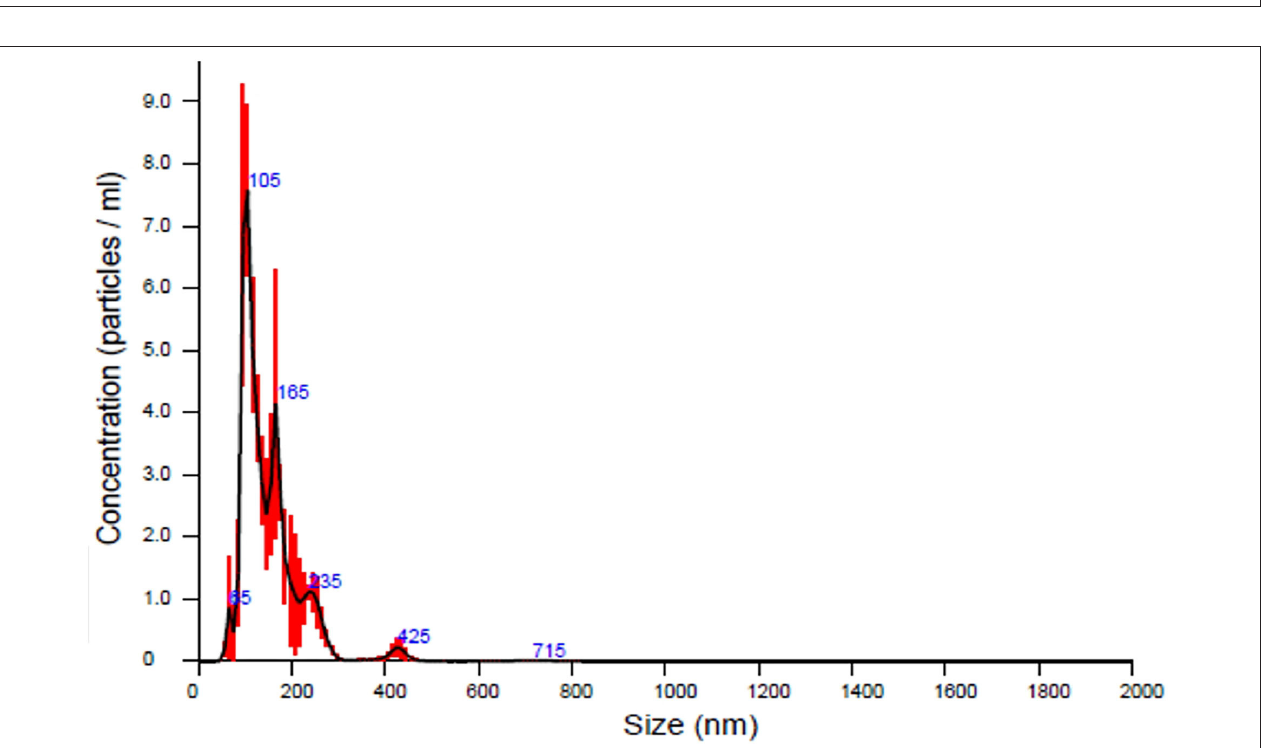
confluence in a 10 cm culture dish, the culture medium was removed, and cells were washed with DPBS.